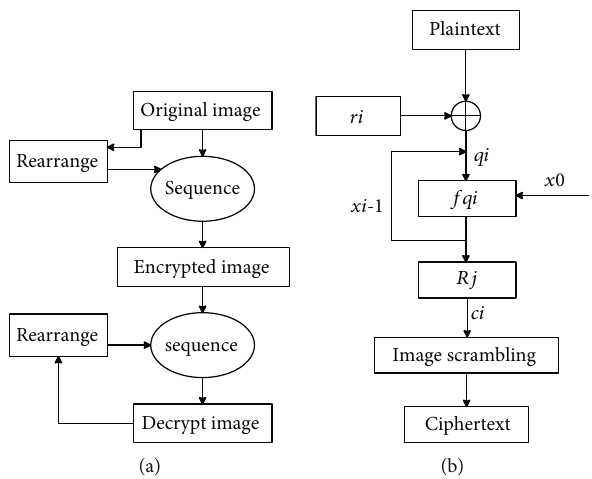
Figure 2: (a) The detailed implementation principle fl owchart of image scrambling password. (b) Digital image encryption based on compound chaotic and image